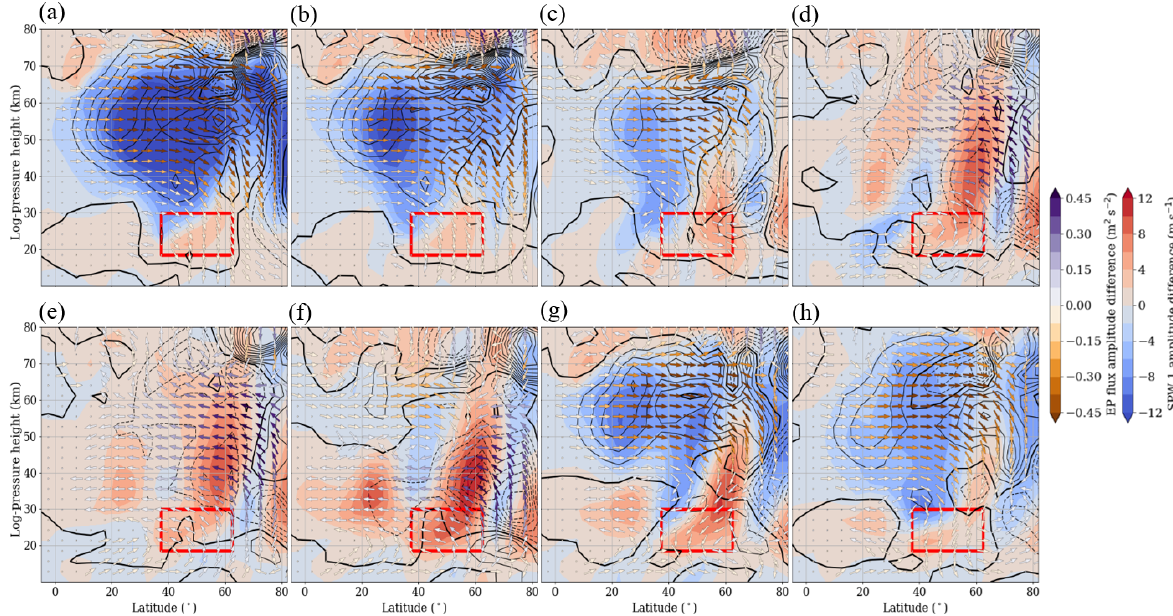
Figure 5. Zonal-mean EP flux (arrows) and EP flux divergence (isolines, negative values are dashed) and zonal wind SPW 1 amplitude (color coding) differences between all H1–H8 (a–h) simulations and the reference simulation (H1–H8 – Ref). The positions of the GW hotspots are shown by red